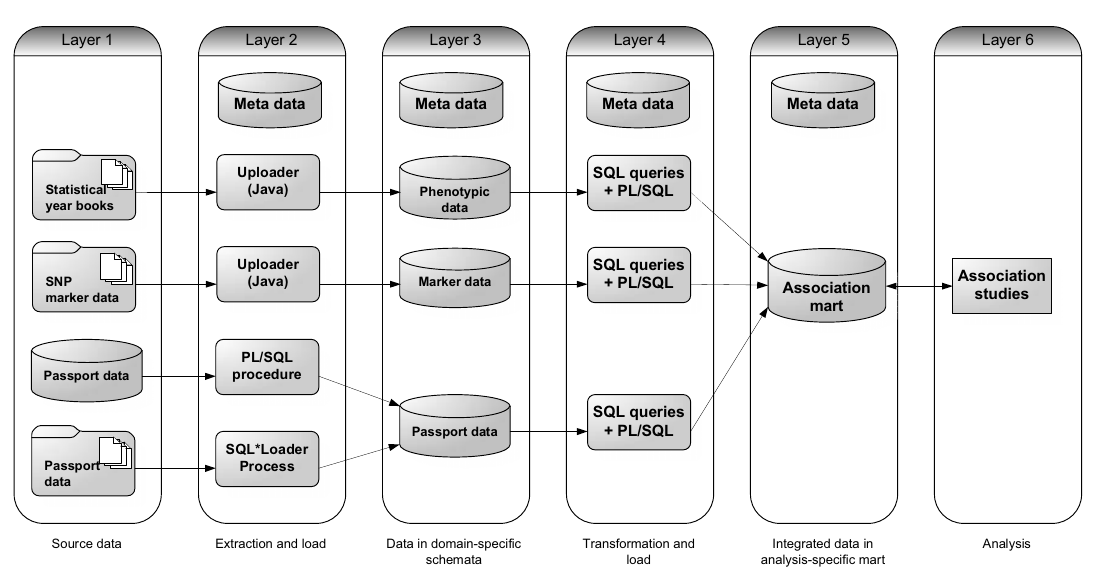
Figure 5: Implementation of our architecture for the barley association